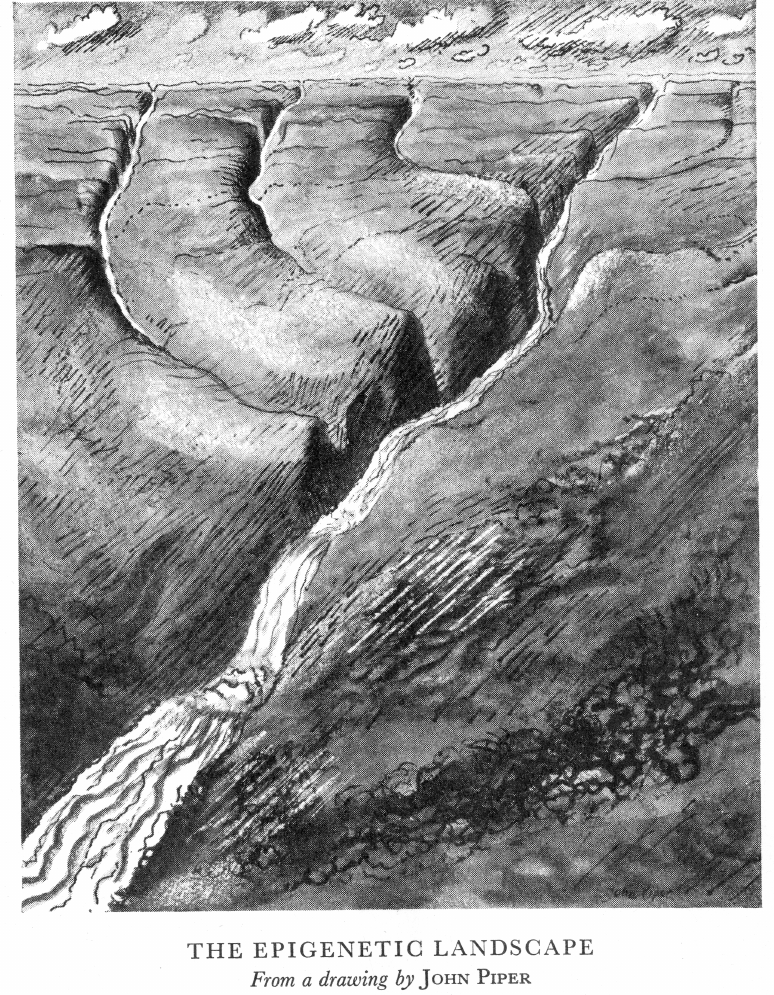
The Epigenetic Landscape , from Conrad H. Waddington, Organizers and Genes (Cambridge, UK: Cambridge University Press, 1940), frontispiece (photo: